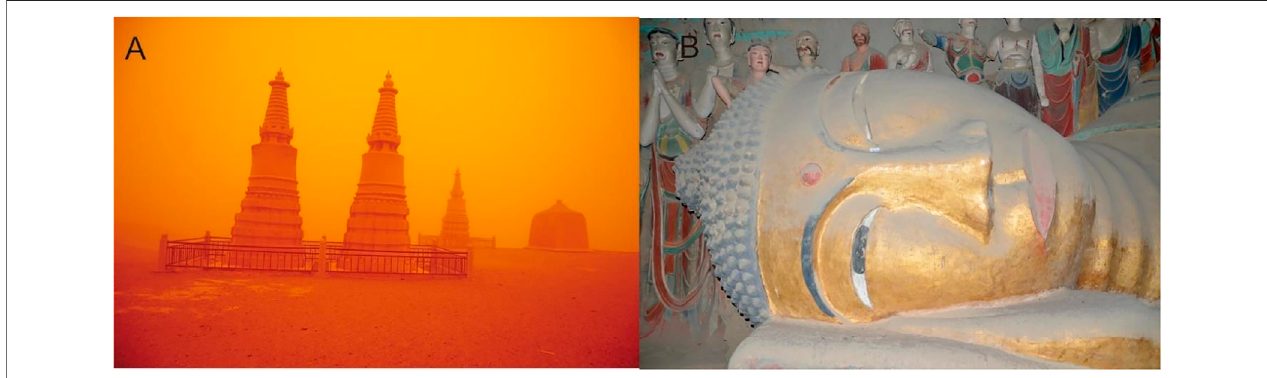
FIGURE 1 | A severe dust storm in the Mogao Grottoes (A) and the painted sculptures in caves are covered by falling dust particles (B)